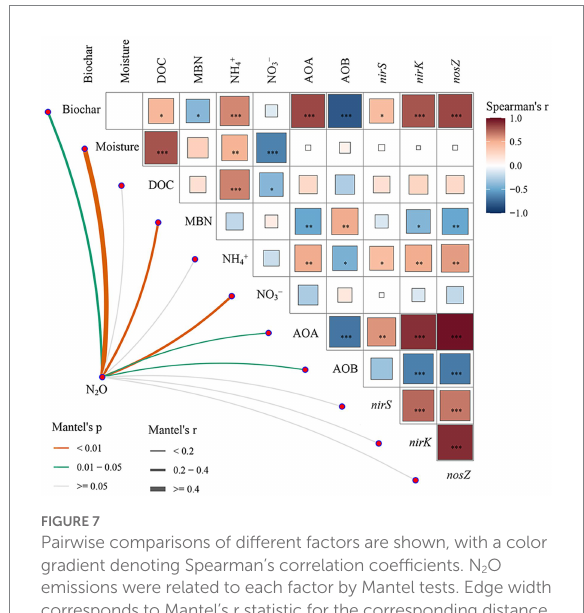
FIGURE 7 Pairwise comparisons of different factors are shown, with a color gradient denoting Spearman’s correlation coefficients. N 2 O emissions were related to each factor by Mantel tests. Edge width corresponds to Mantel’s r statistic for the corresponding distance correlations, and edge color denotes the statistical significance based on 9,999 permutations. * , ** , and *** indicate p < 0.05, p < 0.01, and p < 0.001,